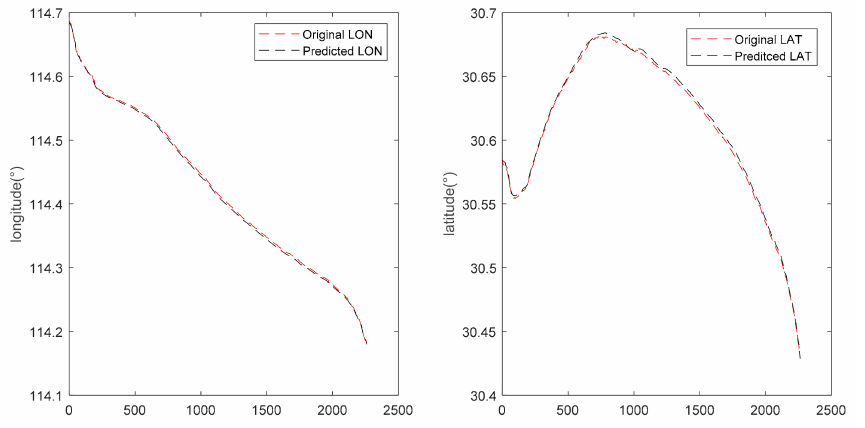
Figure 7. Prediction results of LON and LAT of